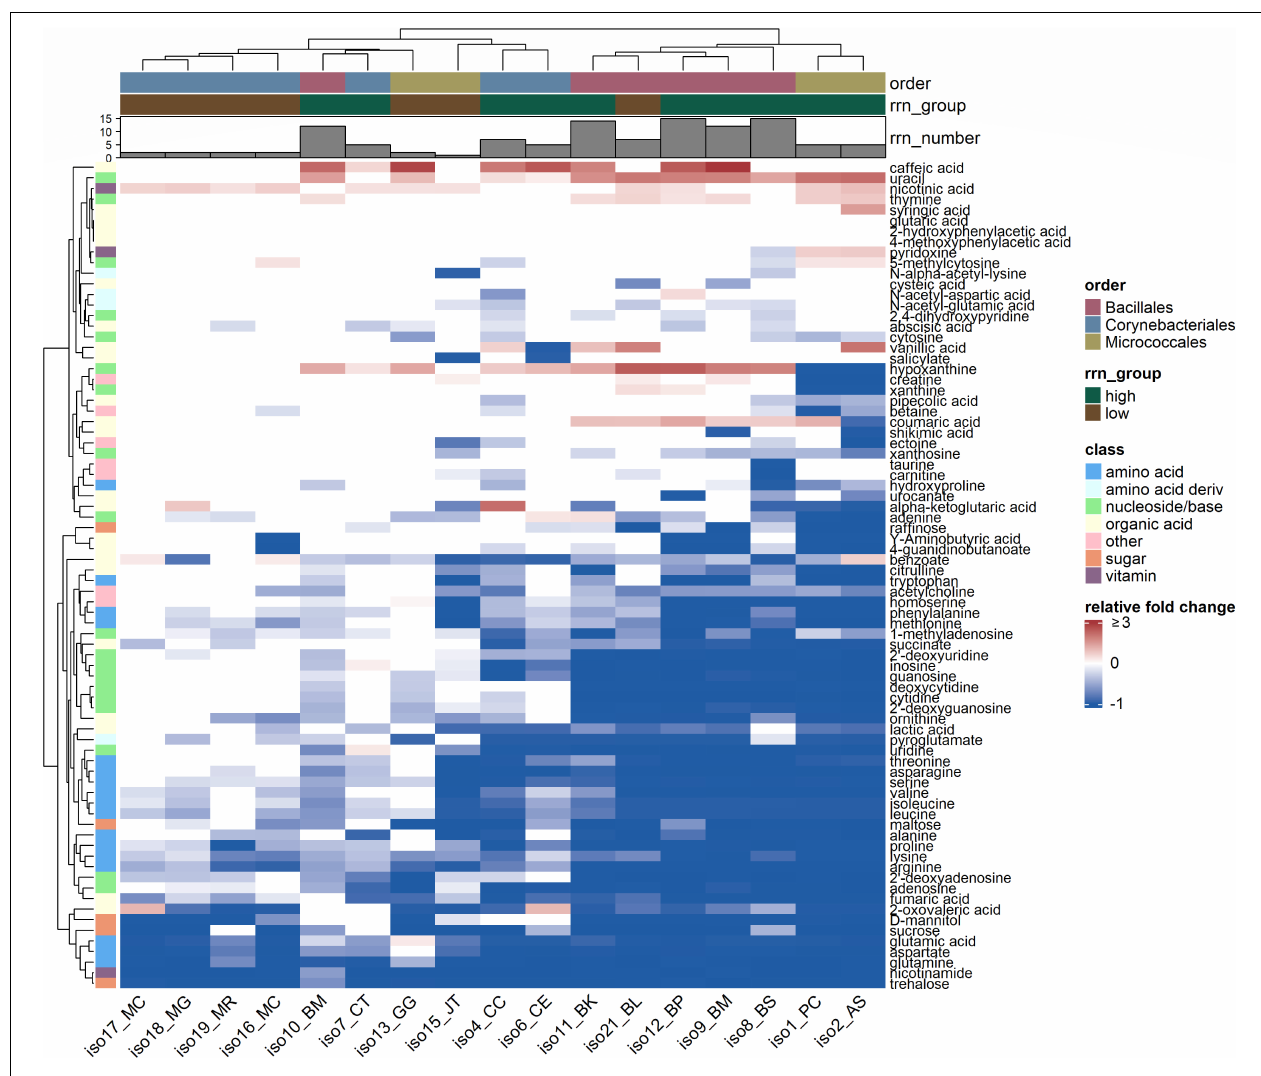
FIGURE 2 | Relative fold changes of metabolite abundances in isolate spent media as compared with the soil defined medium control. Values are displayed as the mean of three replicates. A positive (red) or negative (blue) value indicates isolate production or depletion of that compound in the soil defined medium, respectively. For compound whose abundance did not differ significantly between spent and control media, relative fold change was 0 and shown in white ( p > 0.05, one-way ANOVA with post hoc Dunnett’s test). Metabolites are annotated by compound class. Isolates are annotated by phylogenetic order, order-specific rrn copy group (i.e., high vs. low within each order), and absolute rrn copy number present in the genome.